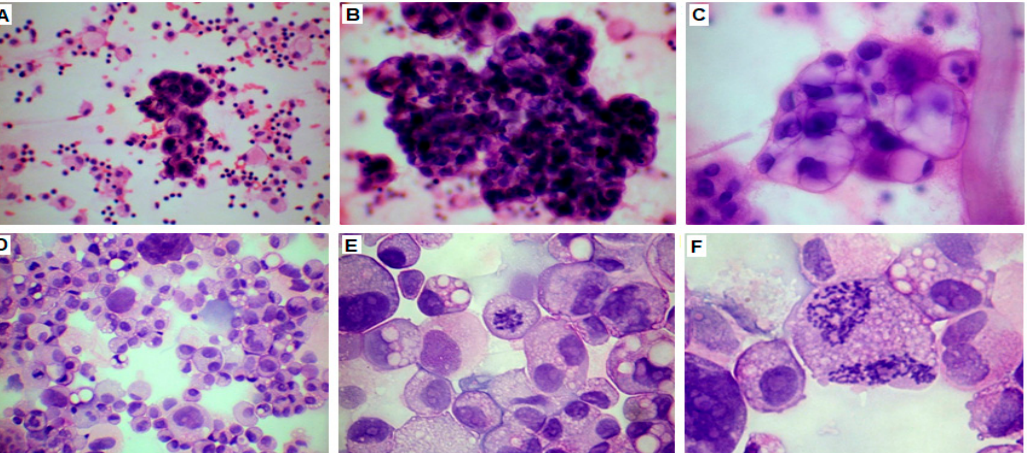
Figure 2. HE staining of ascitic fluid preparations. ( A , D ) Cellular fraction of ascitic fluid was heterogenous. ( A ) Tumor cells forming characteristic pseudopapillary structures are visible in the center, multiple red blood cells and leukocytes are visible throughout, and other non-cancerous cells correspond to fibroblasts and mesothelial cells; ( B , C ) Cancer cells, with polymorphous, hyperchromatic nuclei forming papillary structures; ( E , F ) Pathological mitoses and numerous nucleoli (magnification: 40× ( A ); 100× ( B , D ); 200× ( C ); 400× ( E , F )).